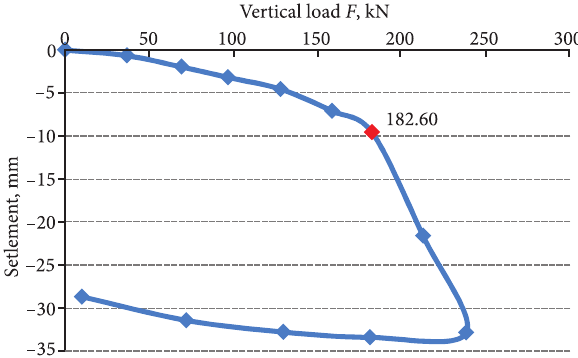
fig. 11. Distribution of normal stress during static vertical load test when the 1 st model pile was at a depth of 1.1 m